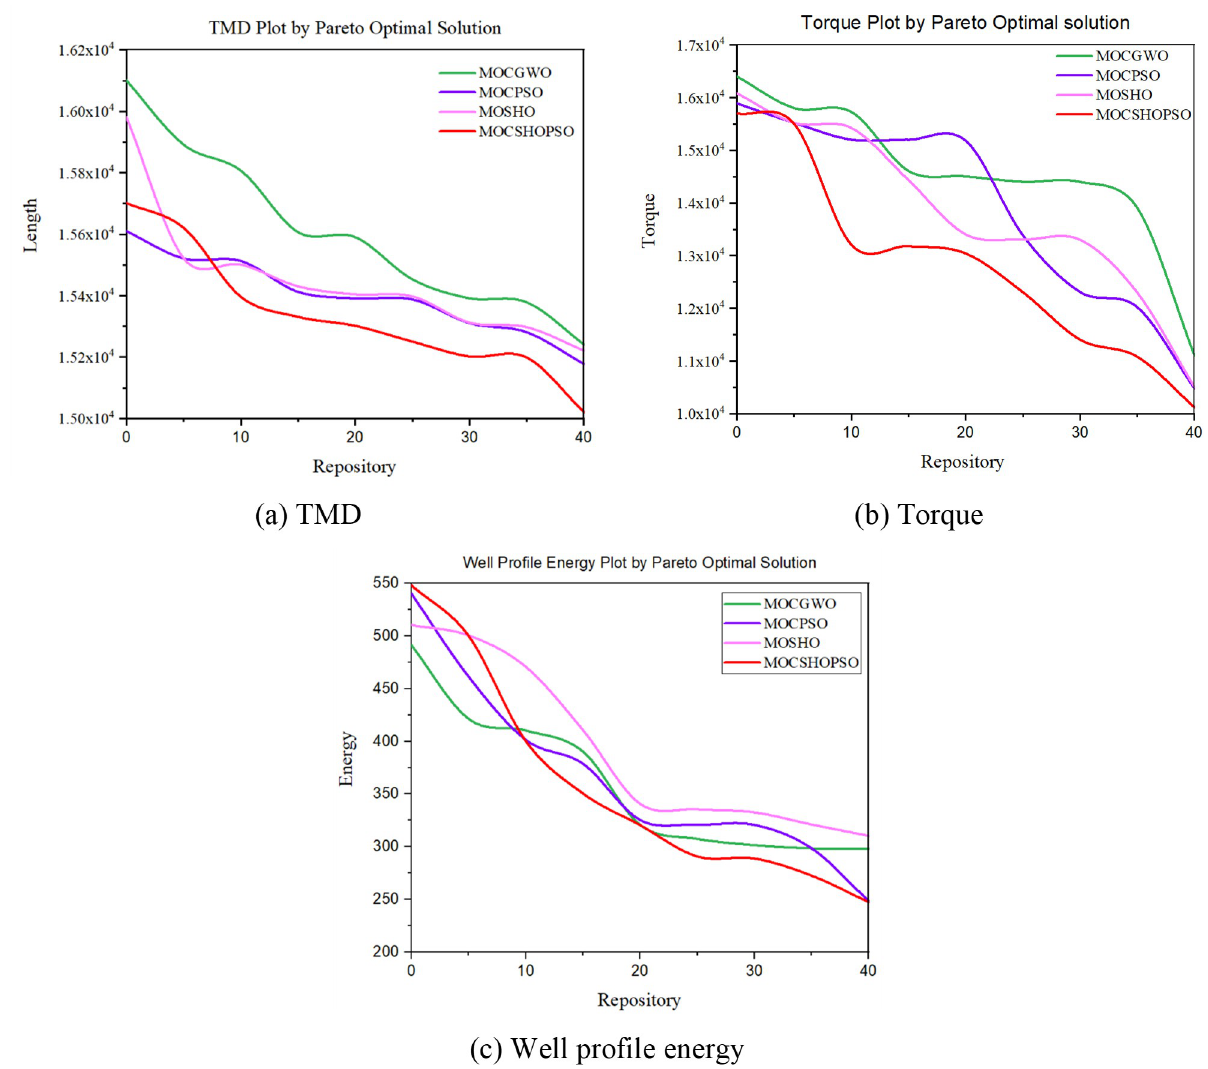
Fig 9. Repository solutions for the studied three objectives. (a) TMD. (b) Torque. (c) Well profile energy.